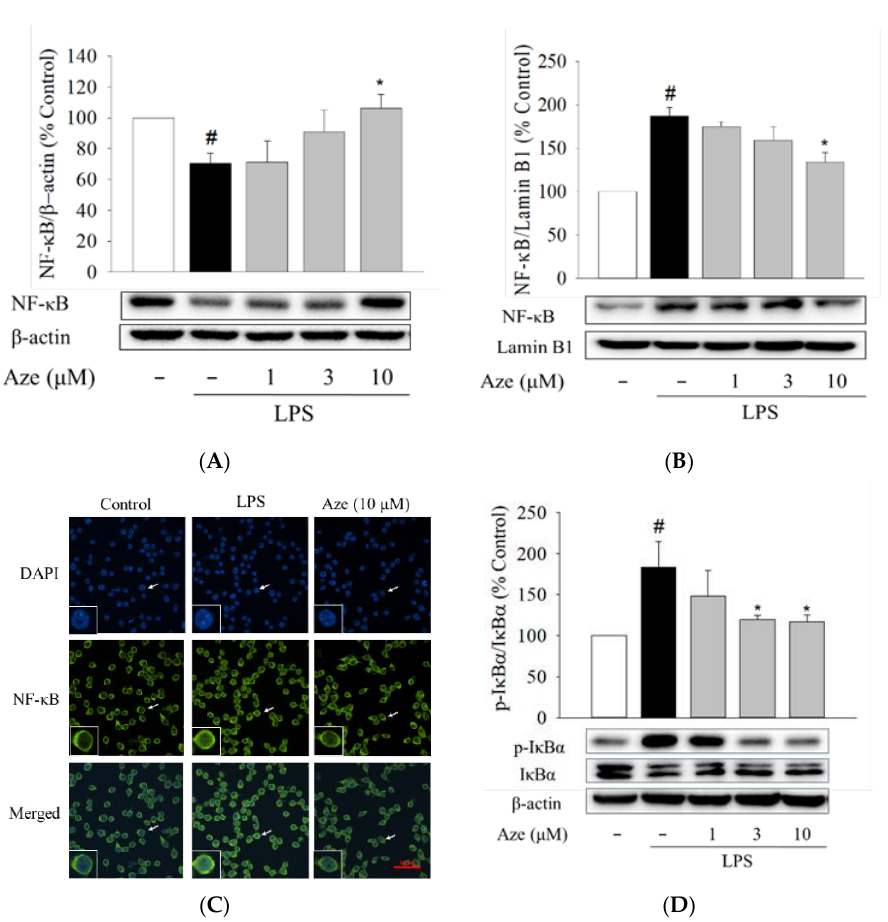
Figure 7. Aze suppressed the LPS-induced nuclear translocation of NF-κB by inhibiting the phos- phorylation of IκBα. BV2 cells were treated with various concentrations of Aze in the presence of LPS (1 μg/mL) for 24 h. Control cells were treated with vehicle alone. Protein expression levels for cytosolic NF-κB ( A ) and nuclear NF-κB ( B ) were evaluated by western blotting using anti-NF-κB p65 antibodies. β-Actin and lamin B1 were used as loading controls for the cytosolic and nuclear fractions, respectively. Representative blots are shown. Data are presented as the mean ± SEM from at least three independent experiments. Immunofluorescence images showing inhibition of NF-κB nuclear translocation by Aze ( C ). Cells were co-treated with LPS (1 µg/mL) and Aze (10 µM) for 24 h, and immunocytochemical analysis was carried out using DAPI and anti-NF-κB p65 antibodies, as described in the Materials and Methods. Representative images are shown. The arrow in each image indicates the magnified cell shown in the inset. Scale bar, 50 µm. Western blotting analyses were conducted using anti-phospho-IκB and anti-IκB antibodies ( D ). Cells were co-treated with LPS (1 µg/mL) and a series of concentrations of Aze for 24 h. β-Actin was used as an internal control. Data are presented as the mean ± SEM from at least three independent experiments. # p < 0.05 and * p < 0.05 vs. vehicle-treated control and LPS-treated cells, respectively.